Question: Sum up the contents of this chart in one sentence.
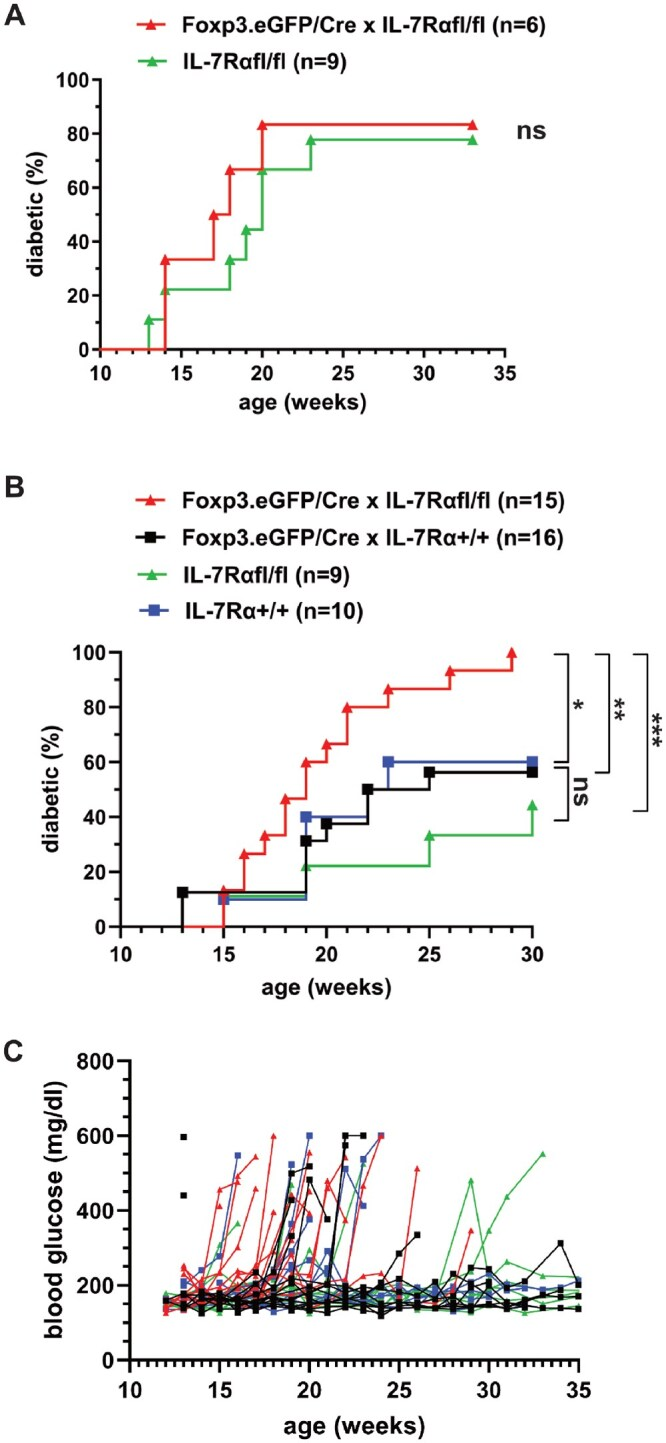
Answer: NOD mice with IL-7Rα-deficient Foxp3 + Tregs show increased T1D incidence. Blood glucose levels were measured weekly in female NOD.IL-7Rα fl/fl (green triangles), NOD.Foxp3.eGFP/Cre × IL-7Rα fl/fl (red triangles), NOD.Foxp3.eGFP/Cre × IL-7Rα +/+ (black squares), and NOD.IL-7Rα +/+ (blue squares) mice starting at 8 or 12 wks of age. Mice were considered diabetic after two consecutive blood glucose measurements ≥ 250 mg/dL. Kaplan–Meier plots show diabetes incidence in the indicated strains at (A) Boston University Medical Campus, and (B) National Jewish Health. (C) Graph shows weekly blood glucose values from the indicated strains at National Jewish Health. * = P < 0.05, ** = P < 0.01, *** = P < 001.